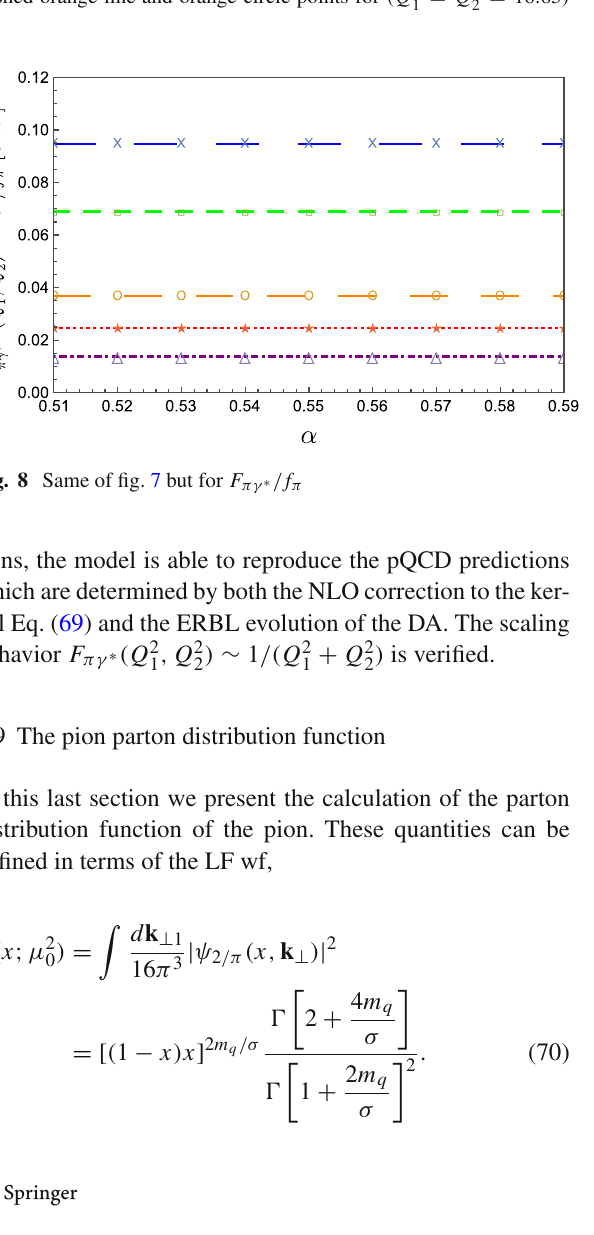
Fig. 7 Thepionvirtualphoton transitionform factorevaluatedatNLO as a function of the parameter α . Lines stand for the GSWL calcula- tions and markers for the pQCD predictions [70]. Long dashed blue line and blue crossed points for ( Q 2 dashed orange line and orange circle points for ( Q 2